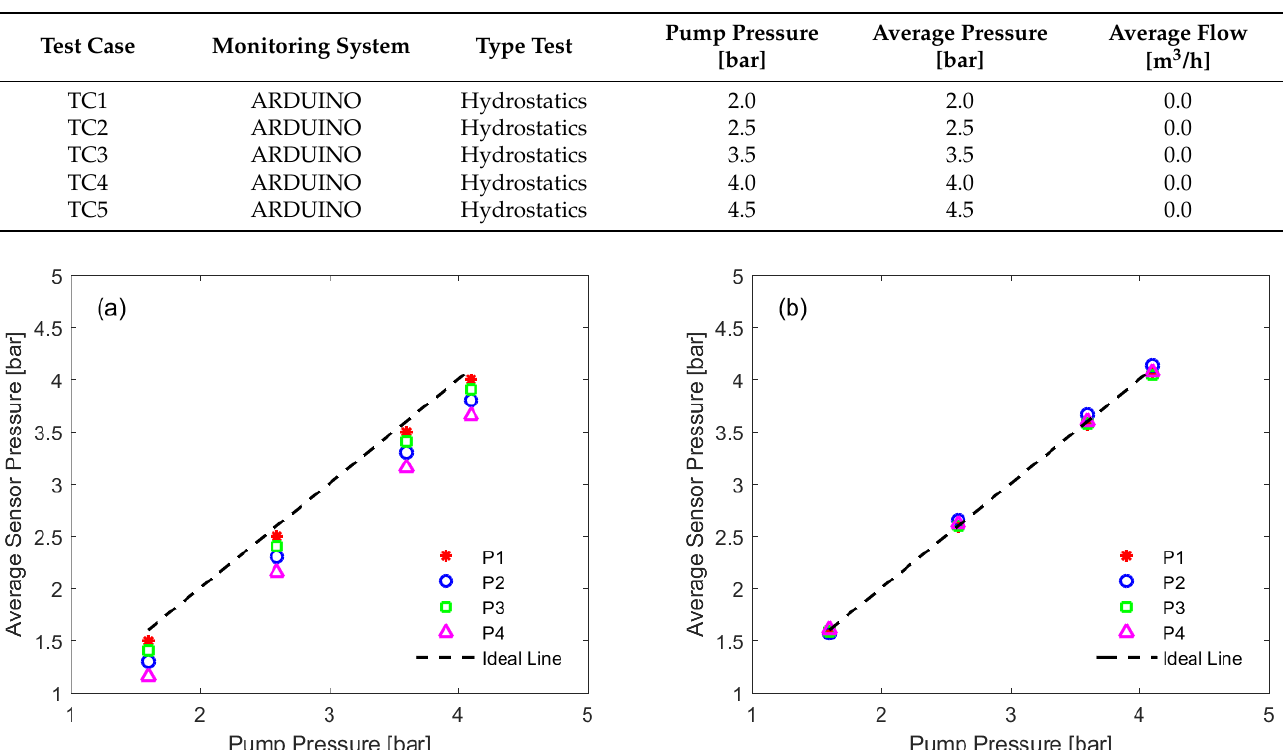
Figure 6. Calibration of the pressure transducers. ( a ) measured data before the calibration; ( b ) measured data after the